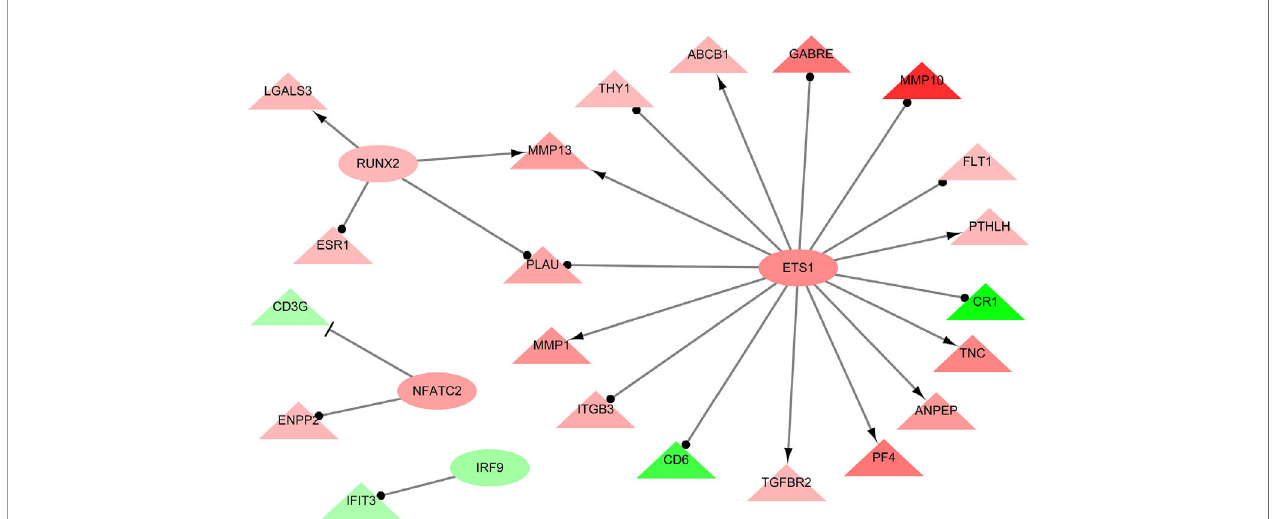
FIGURE 6 | The interaction network showing the relationships between differentially expressed transcription factors (DETFs) and their corresponding target genes. Ovals and triangles represent DETFs and their target genes, respectively. Red and green denote genes with increased and decreased expression, respectively. Arrows with a T-shaped end represent inhibition or repression of gene expression, arrows with a delta-shaped end represent gene activation, and arrows with a dot- shaped end represent unknown regulatory type. Network was constructed using Cytoscape and TRRUST database. The details of DEGs are listed in Supplementary Table S2